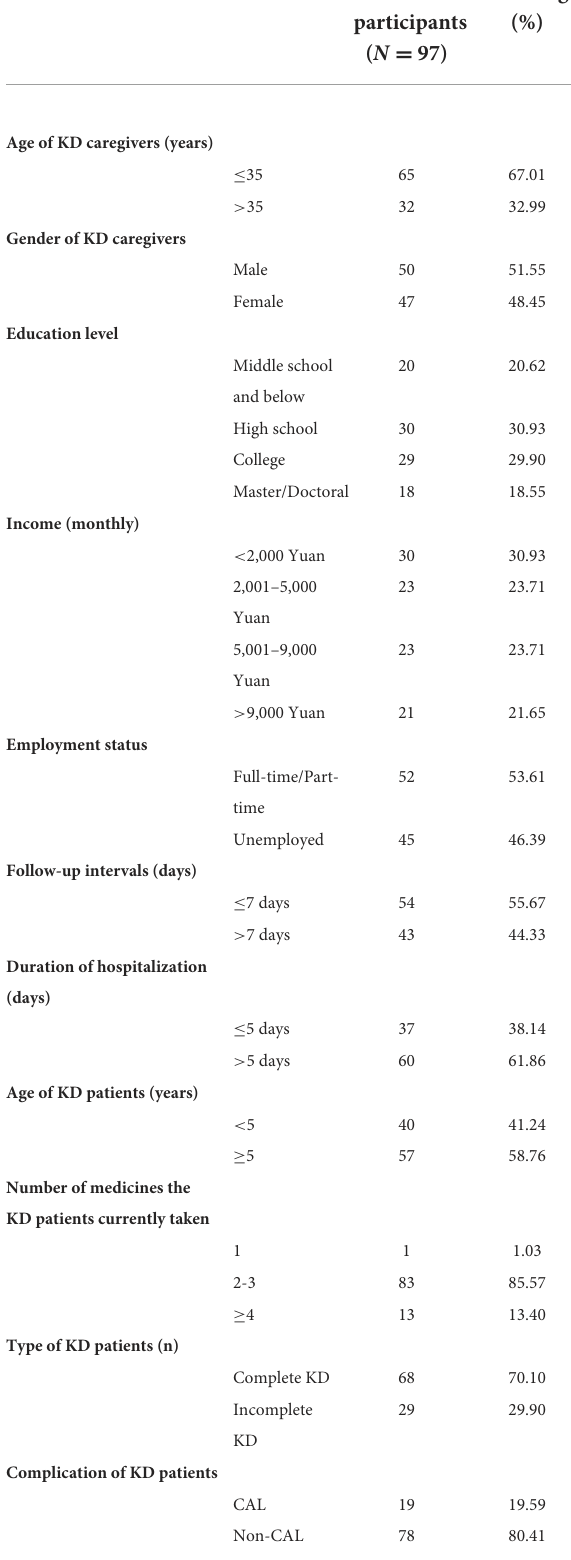
TABLE 1 General characteristic of KD caregivers and KD patients.